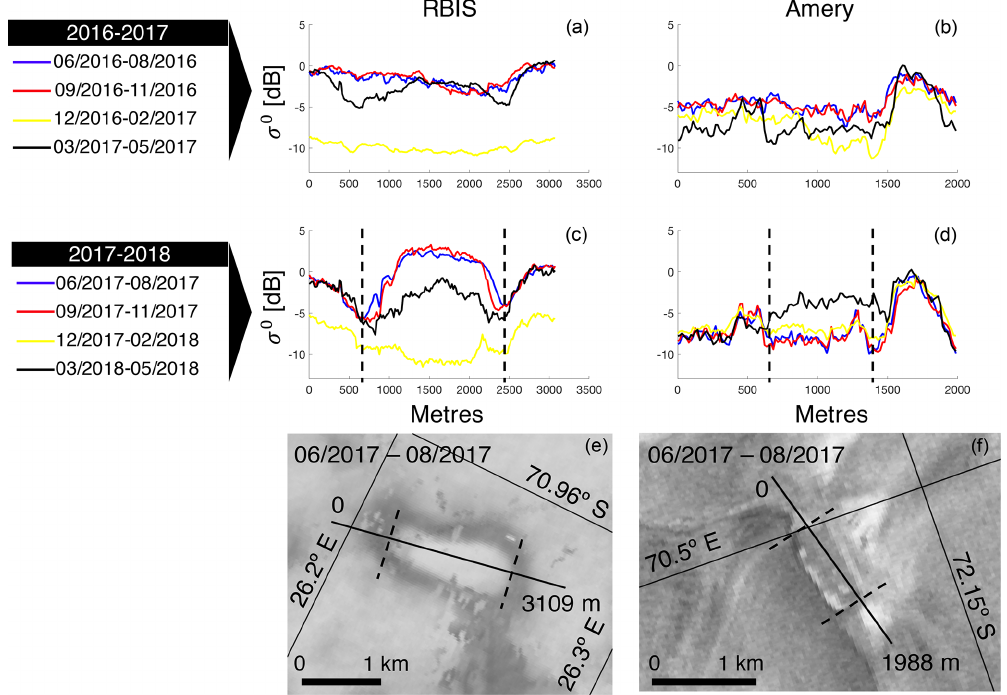
Figure 4. Spatial variation in Sentinel-1 σ 0 for two different lakes: RBIS a (see Fig. 1) (a, c, e) and Amery d (b, d, f) . Panels (a, b) and (c, d) show the mean backscatter intensities over the lake transect for the June 2016 to May 2017 and the June 2017 to May 2018 periods, respectively. Each curve represents the average σ 0 over a quarter year of observations. The transects as well as the 2D winter appearance of the feature and its surroundings are illustrated in (e, f) . The σ 0 images are acquired from Google Earth Engine (Gorelick et al.,